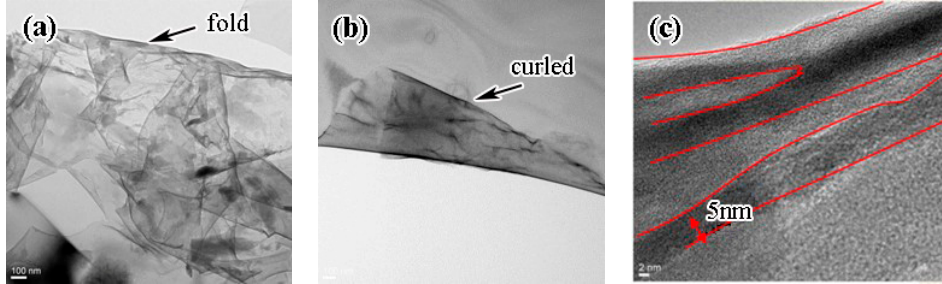
Figure 6. Transmission electron microscopy (TEM) images of the dark grey phase in the GO/TiAl composites. ( a ) shape of fold ( b ) shape of curled ( c ) the width of GO.